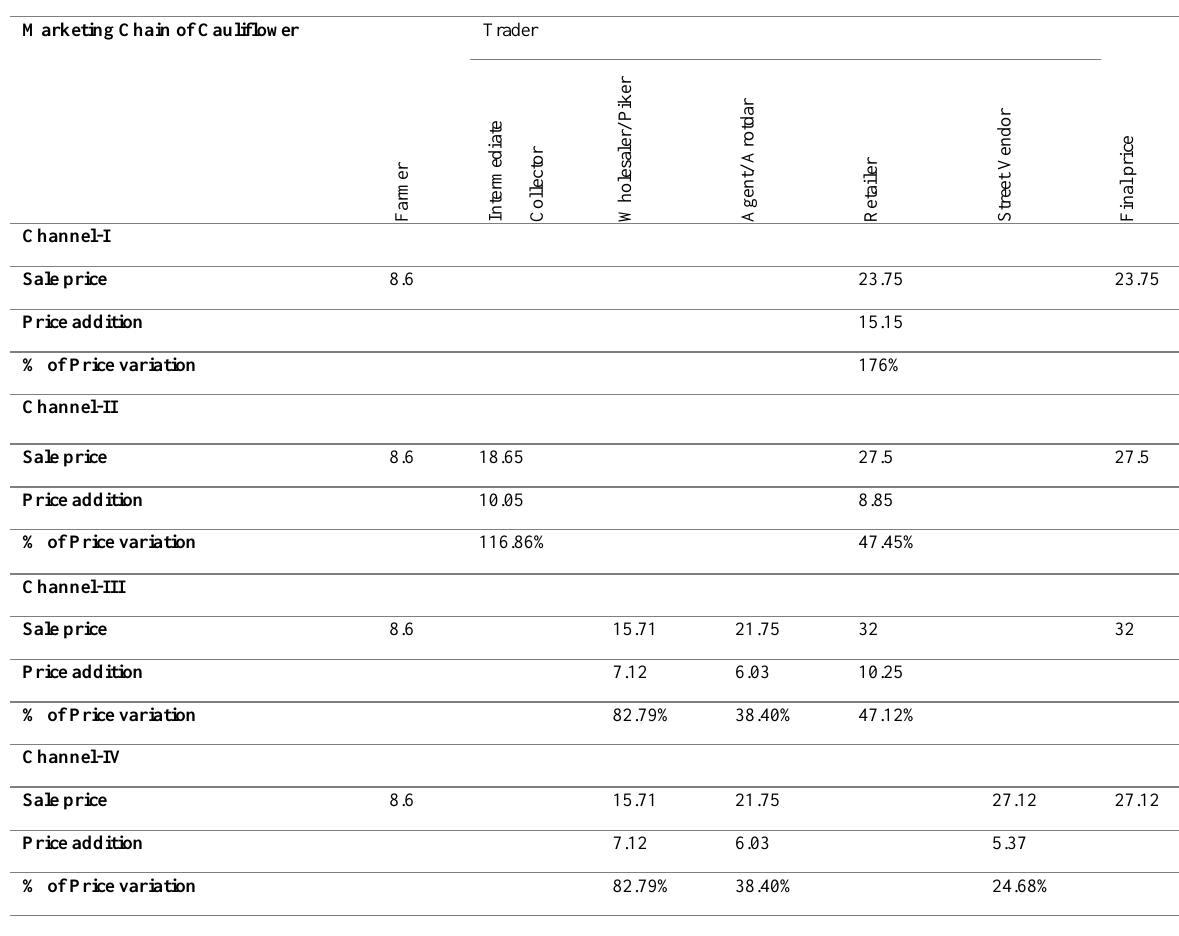
Table 4: Nature of Price Variation in Different Marketing Channels of